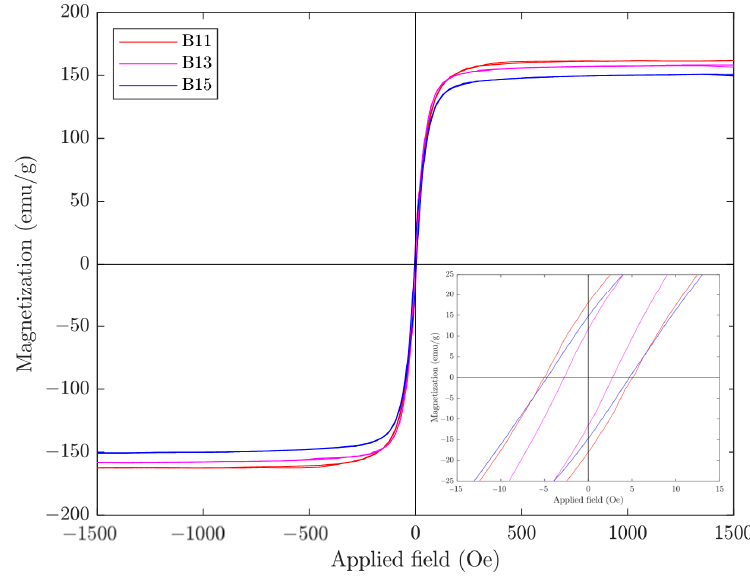
Figure 9. Magnetic hysteresis loops for samples B11, B13, and B15 (room temperature).